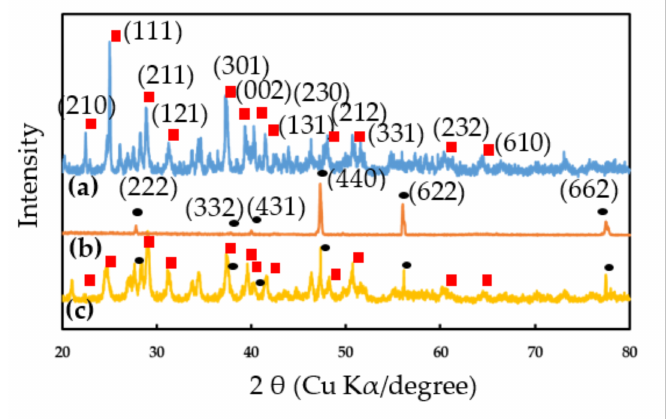
Figure 2. XRD patterns of ( a ) EuCl 2 , ( b ) Eu 2 O 3 and ( c ) EuCl 2 /Eu 2 O 3 blend